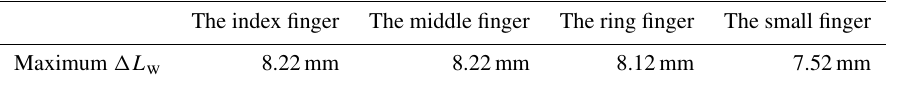
Figure 3. The cable-driven mechanism. Table 3. The required cable length (in millimetres) for each finger.